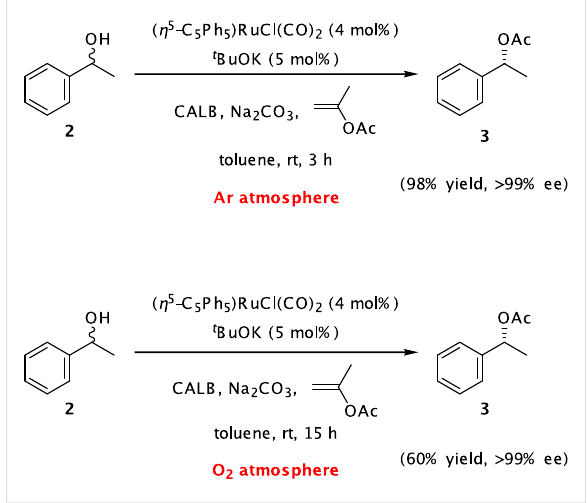
Figure 1: Racemization catalyst 1